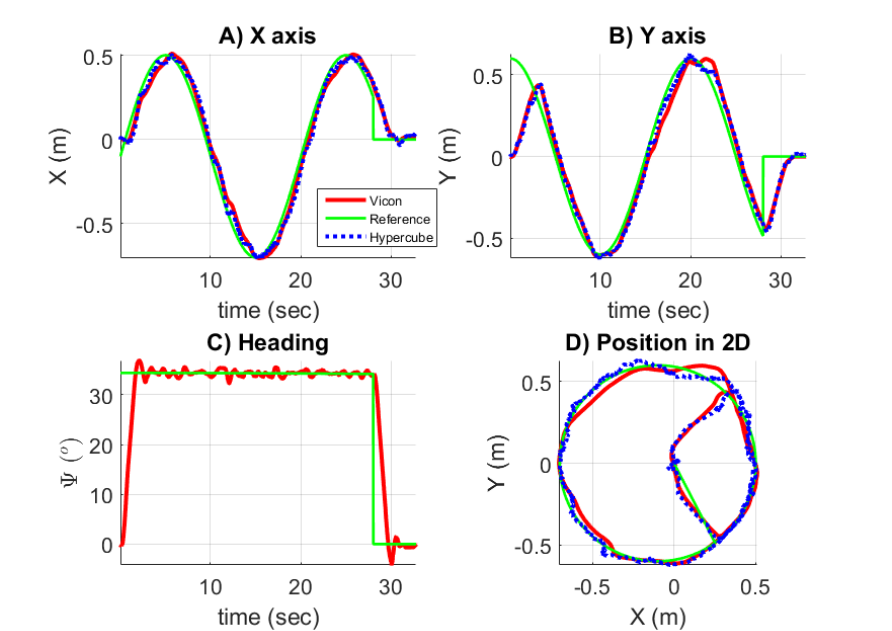
Figure 16. Plots of the position and orientation of the mobile robot while the measurements provided by HyperCube are used in closed loop and the heading is given by the Vicon cameras. Only one IR LED that flickers at 11 kHz is used and H = 2